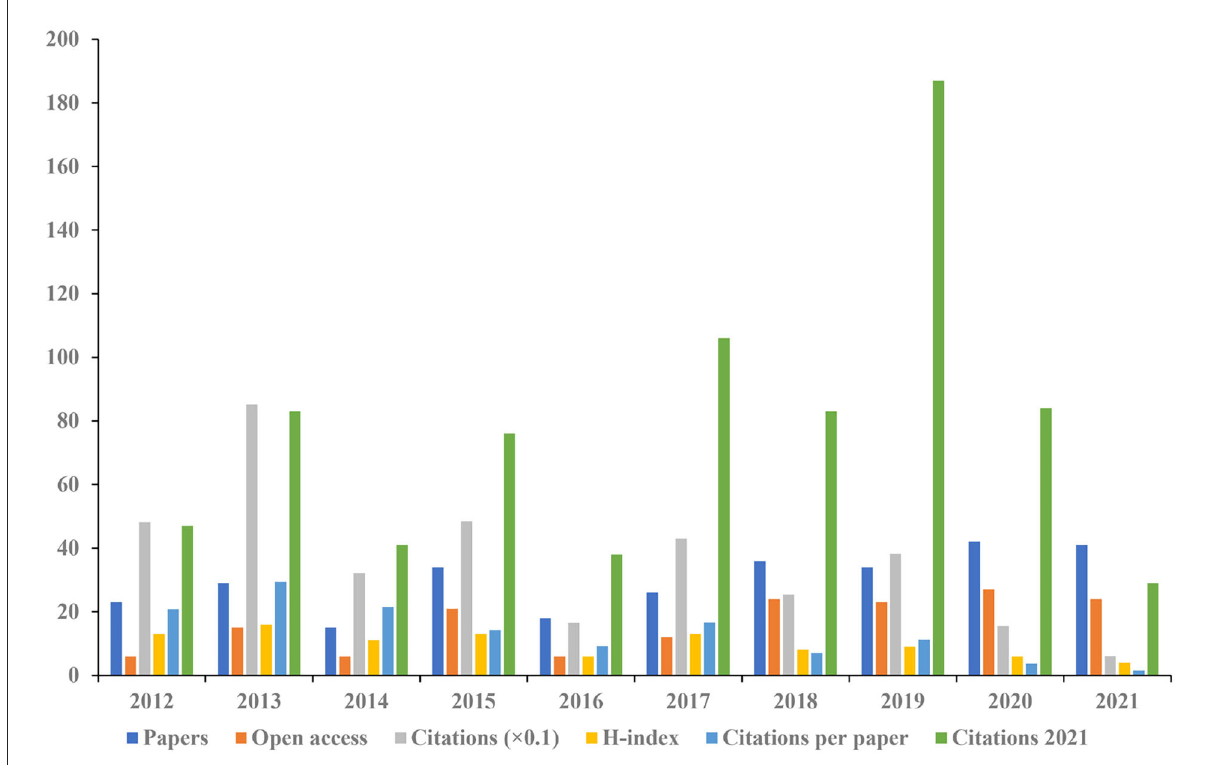
FIGURE3 The number of articles, open-access articles, citations, H-index, citations per paper, and citations in 2021 for each